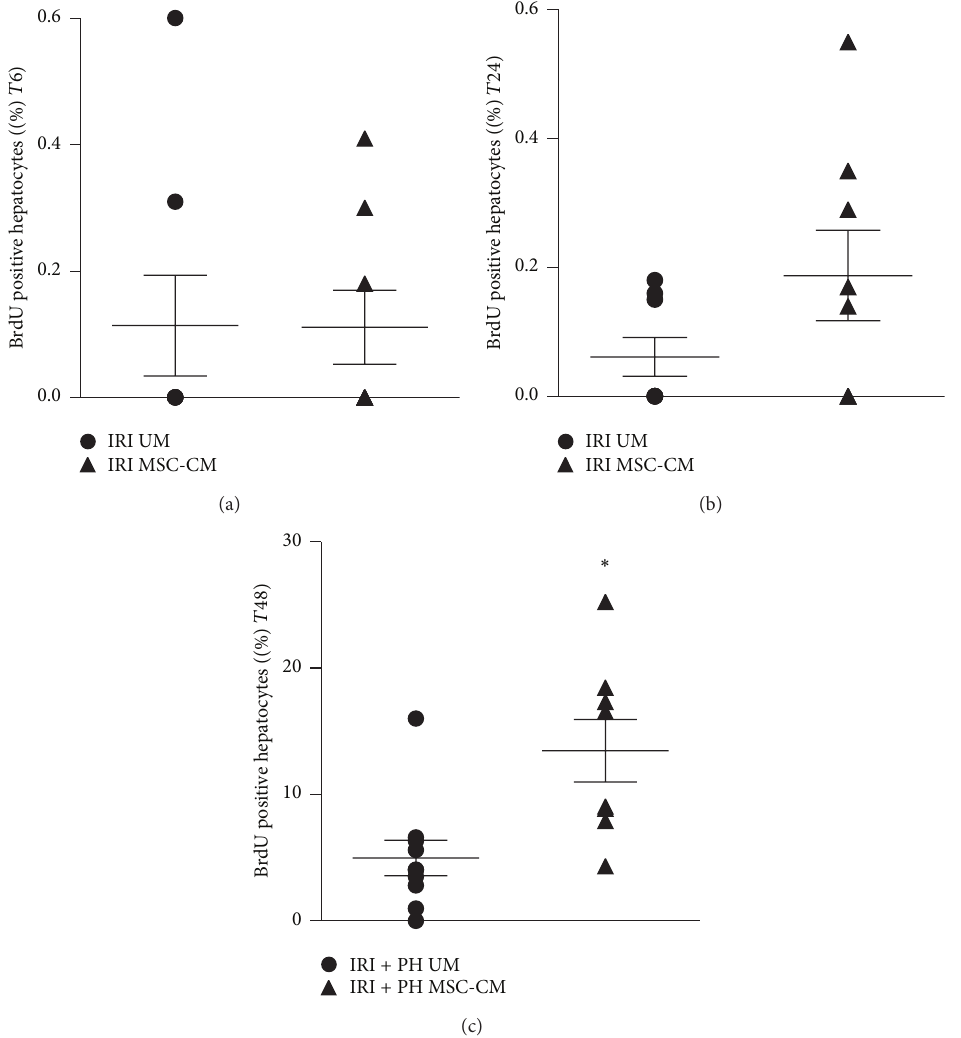
Figure 4: Effects of MSC-CM on hepatocyte proliferation. Livers were processed for immunohistochemistry on BrdU to quantify hepatocyte proliferation. This figure shows the percentage of BrdU positive hepatocytes (a) 6 hours after IRI, (b) 24 hours after IRI, and (c) 48 hours after IRI + PH; ∗ 𝑝 ≤ 0.05